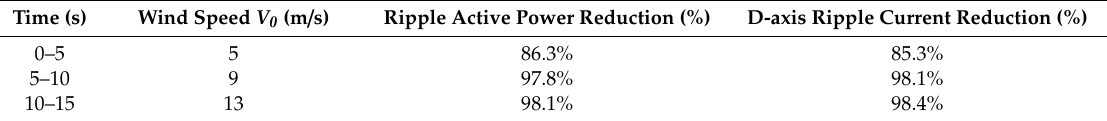
Table 5. Ripple reduction percentage of grid connection point after